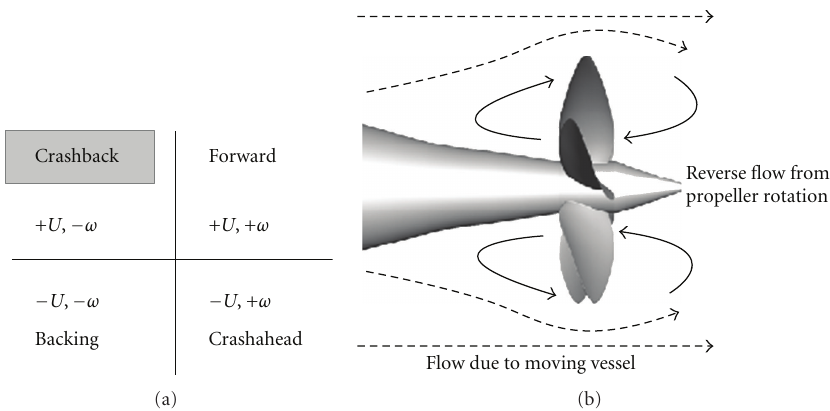
Figure 1: (a) Four-quadrant plot of propeller operating conditions, (b) schematic of flow in crashback condition.